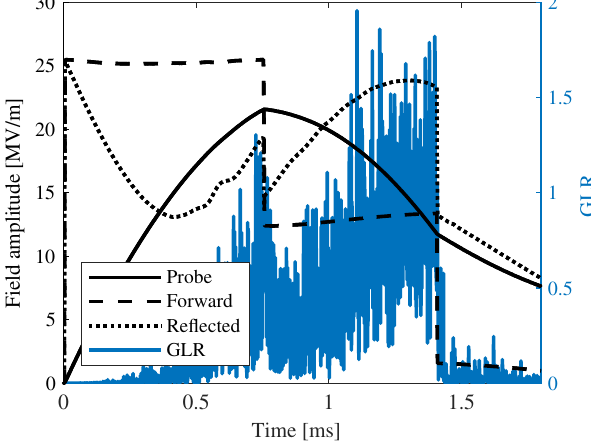
FIG. 14. All signals for changed Q L for pulse 17 from Fig. 12. ¯ λ 10 . 8 is marked in red, dashed-dotted. The threshold of GLR ¼